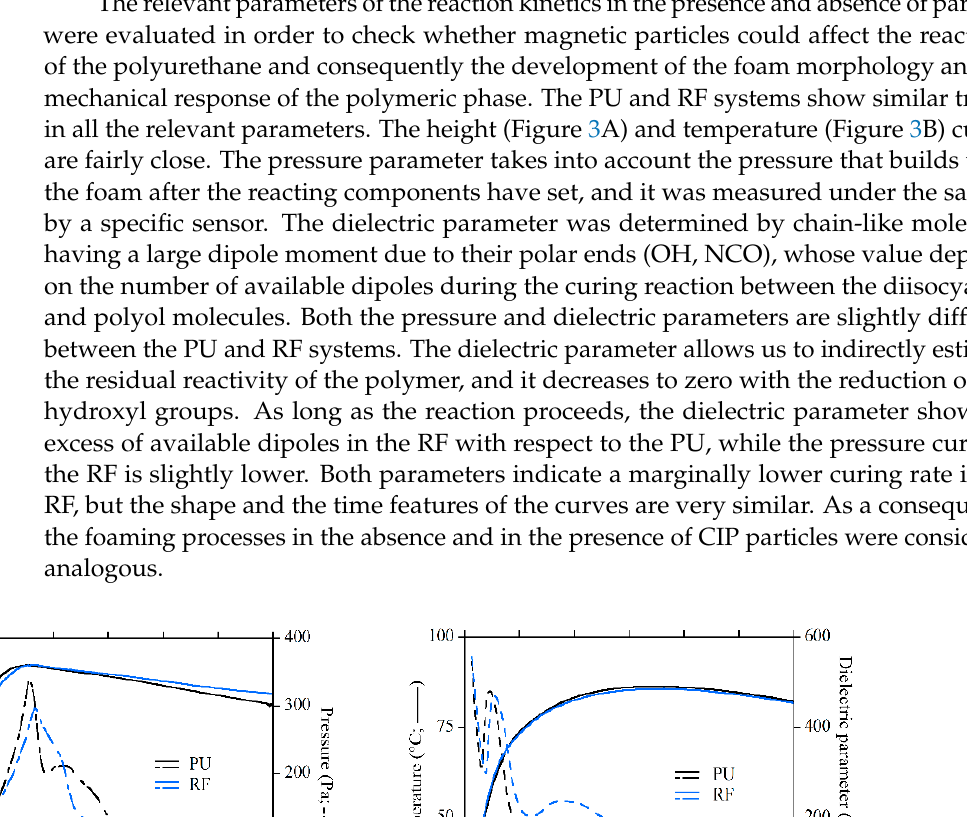
(neat PU foam) and RF (foams with randomly dispersed particles) systems: ( A ) temperature and pressure; ( B ) height and